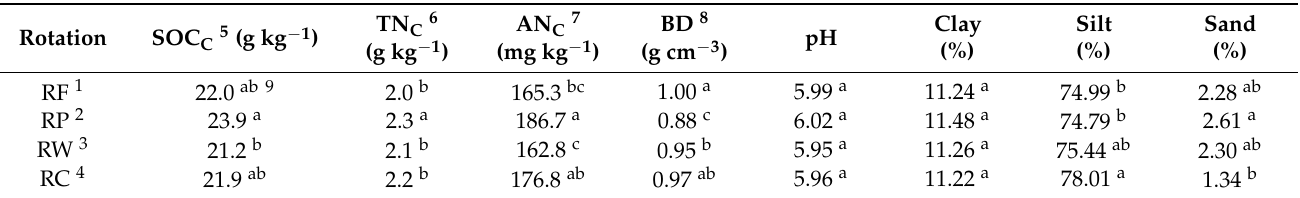
Table 1. Soil properties under different rotations before rice season in 2019 (0–20